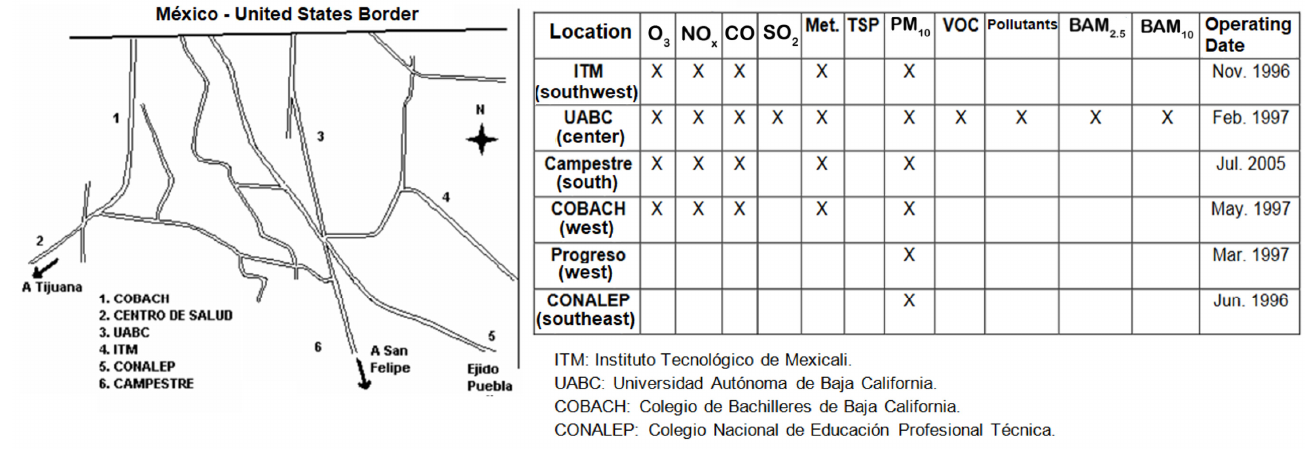
Figure 3. Geographical location of air monitoring stations in Mexicali B.C. and the pollutants they could monitor until 2008. [x] Indicates that the air monitoring stations have the capability to measure pollutants.